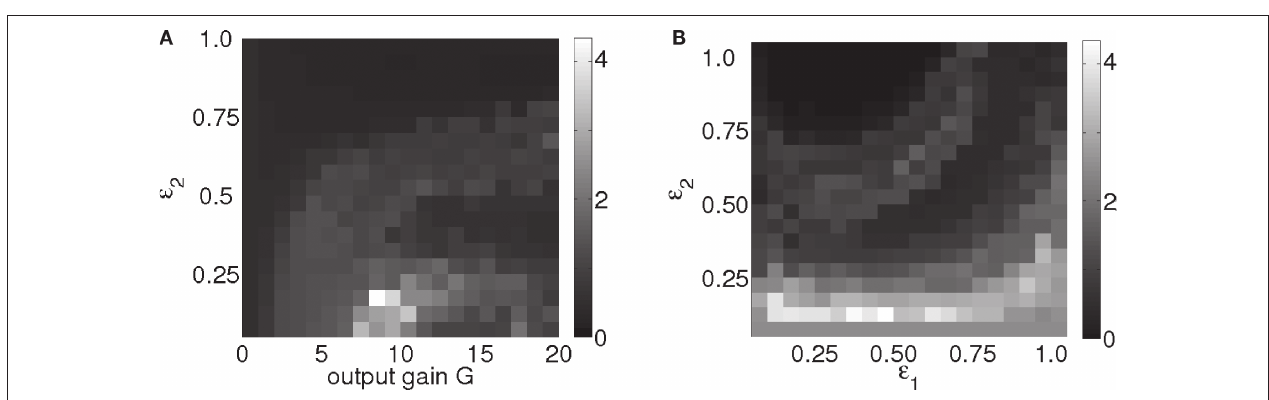
FIGURE 9 | Control scheme of the kneed biped from Figure 8. The variables { ε , ε } linearly couple the chaotic oscillators to their respective limbs (left). 1 2 However, due to their embodiment, the isolated controllers receive dynamically the phase information from the different body parts: the